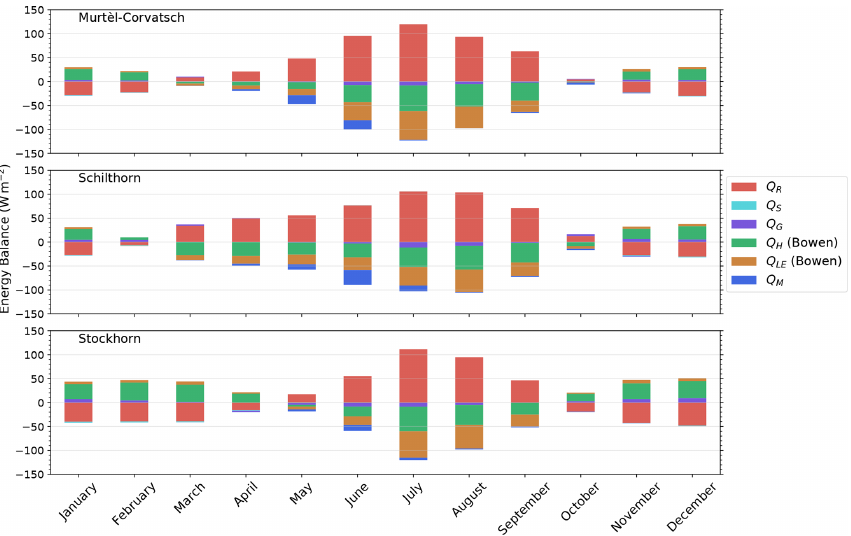
Figure 7. Mean monthly energy balance components for all three stations for the whole observation period: Murtèl–Corvatsch (1997–2018), Schilthorn (1999–2018) and Stockhorn (2006–2018).